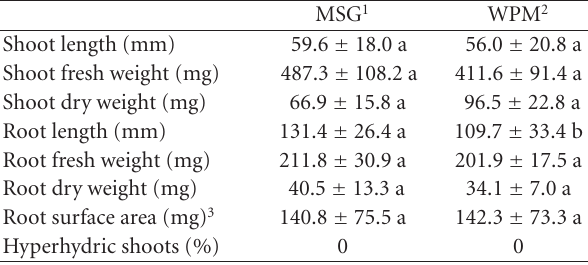
Table 1: E ff ect of di ff erent formulations of basic culture media on seedling growth parameters on in vitro germination of Handroan- thus impetiginosus after 30-day